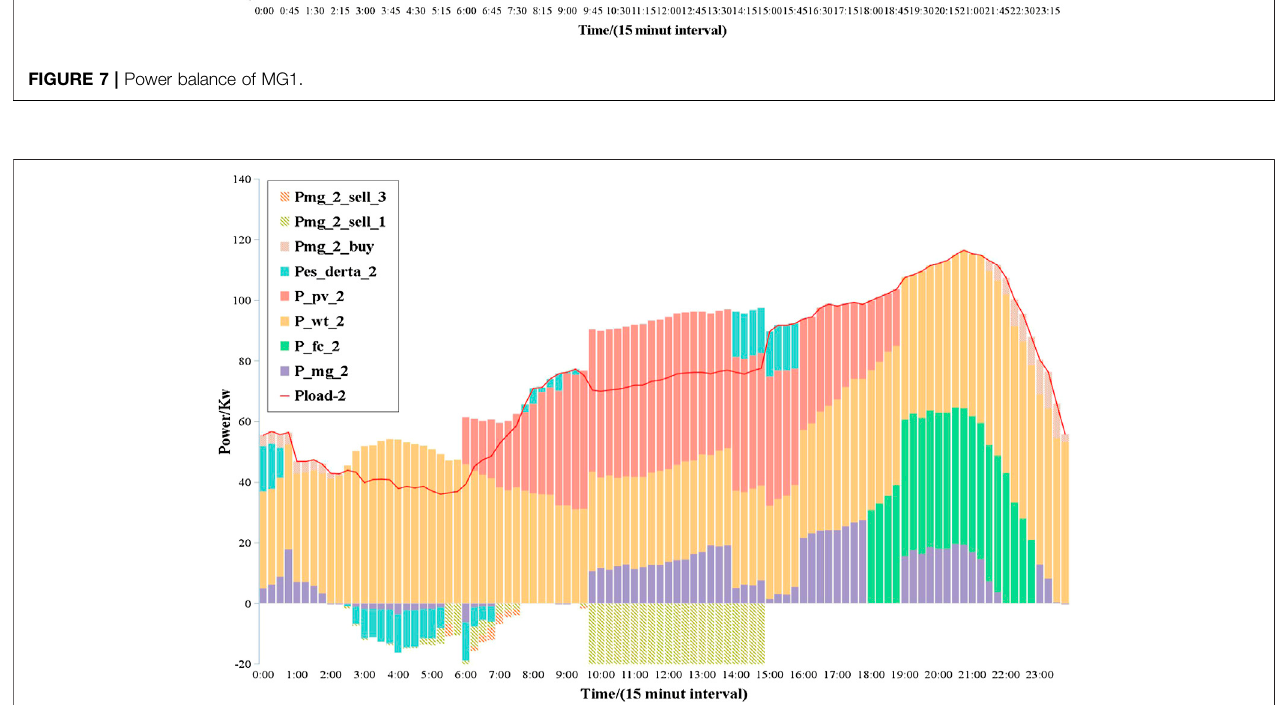
FIGURE 8 | Power balance of